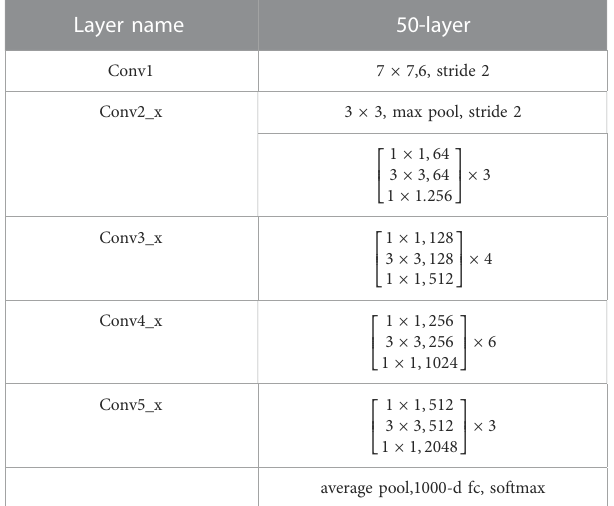
TABLE 2 ResNet50 detects network